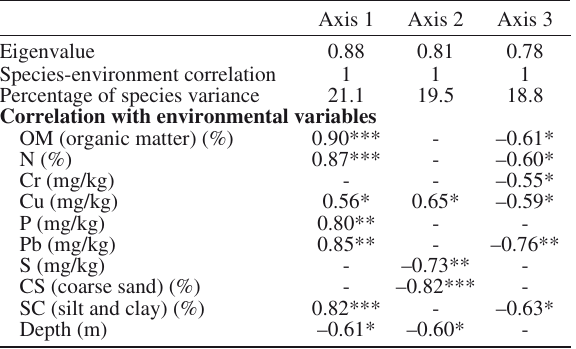
Table 3. – Summary of the results of the CCA analysis. Only the variables that correlated with the first three axes were included. *,